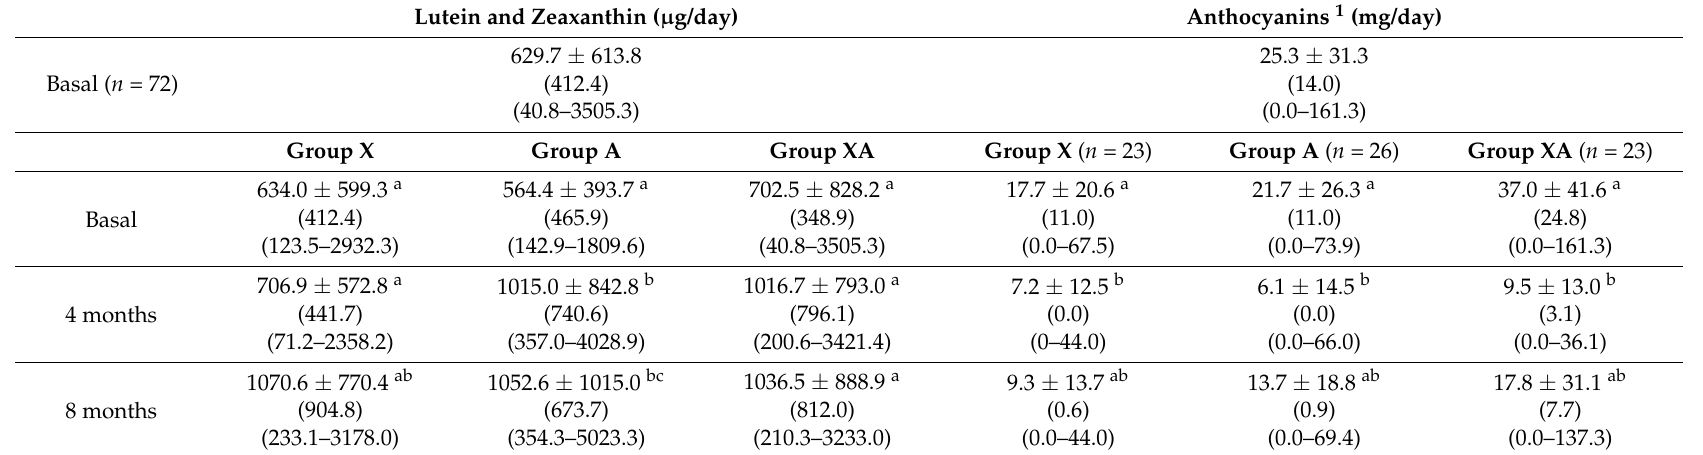
Table 3. Dietary intakes of lutein and zeaxanthin and anthocyanins expressed as means ± SDs, (median) and